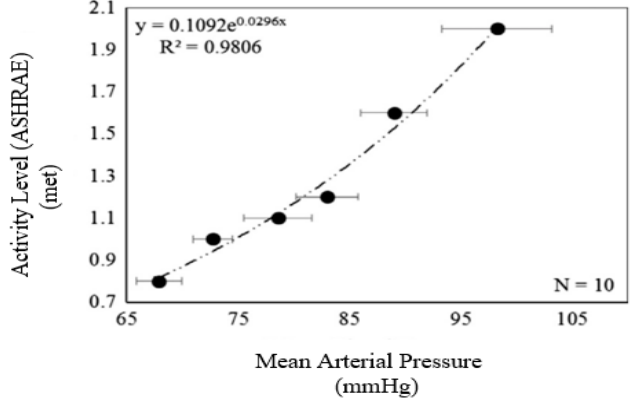
Figure 2. Mean arterial pressure (MAP) and American Society of Heating, Refrigeration and Air-Conditioning Engineering (ASHRAE) metabolic activity.